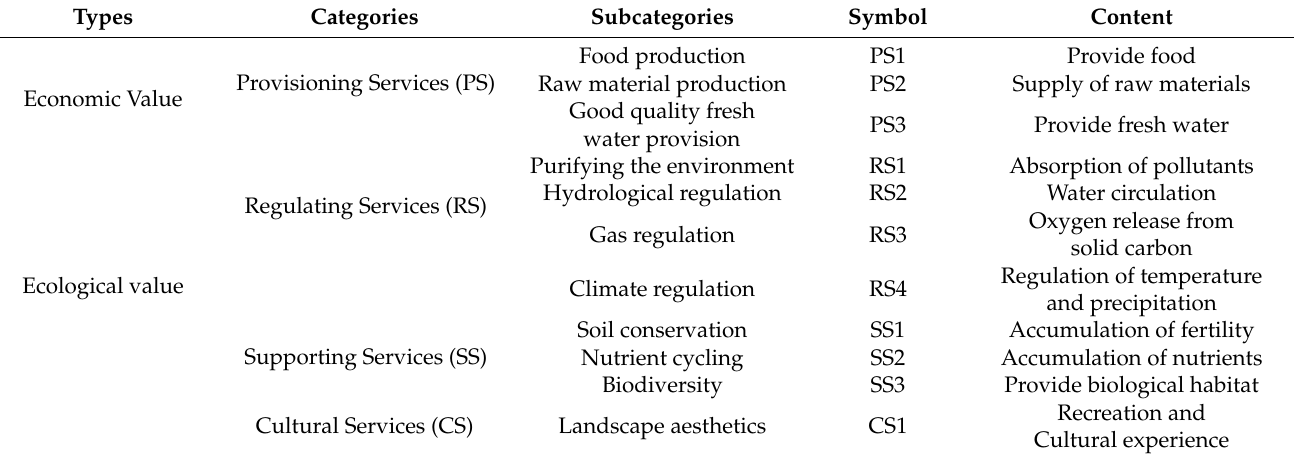
Table 2. Ecosystem service values assessment indicator